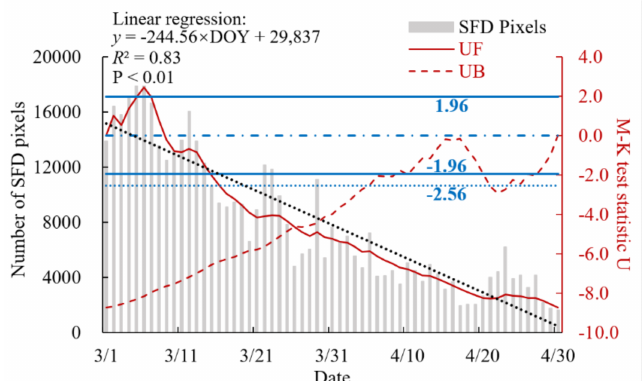
Figure 6. The sequential Mann-Kendall (M-K) test results of SFD pixels for tea planting area from March to April in the middle and lower reaches of the Yangtze River region, China. The gray histogram and black dotted line are daily SFD pixels and its linear regression, respectively (left y -axis). The solid and dashed dark red lines are the M-K test statistics (right y -axis) for forward ( UF ) and backward ( UB ). The dash-dotted blue line is statistic value 0, the solid horizontal dark blue lines are the upper and lower limits of the 95% confidence interval, and the dark blue horizontal dotted line is the lower limit of the 99% confidence